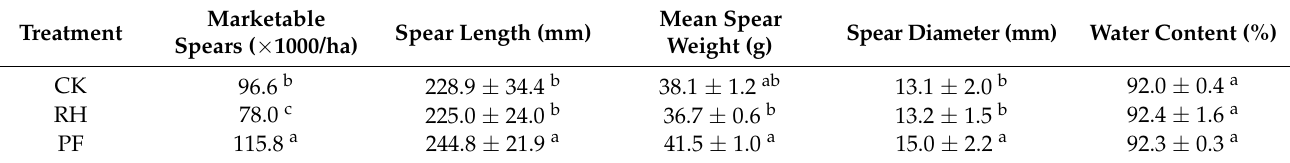
Table 2. The effects of mulching on the number and some features of marketable asparagus spears in early spring. Different lowercase superscript letters within the same column indicate significant differences at p <